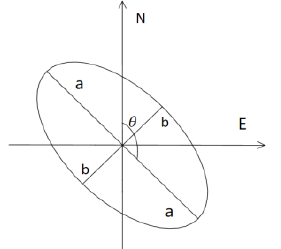
Figure 2. LPA elliptical parameters